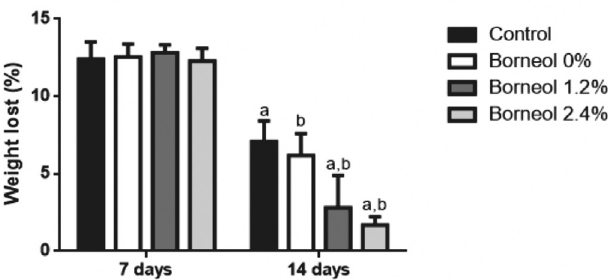
FIGURE 10 - Percentage weight loss according to group and day of experimentation. a p<0.05: Control vs. Borneol 1.2% and Borneol 2.4% (14 days). b p<0.05: Borneol 0% vs. Borneol 1.2% and Borneol 2.4% (14 days) (Two-Way Analysis of Variance ANOVA, followed by Tukey’s